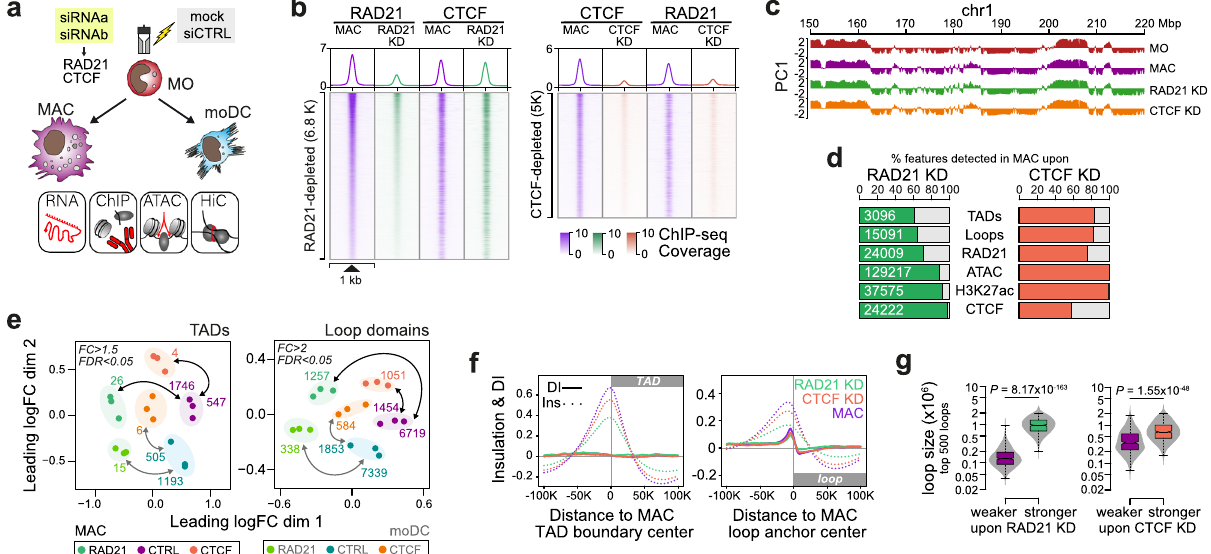
Fig. 5 Cohesin knockdown affects 3D genome architecture during MO differentiation. a Schematic of the experimental setup. MO were either mock- treated or electroporated with control siRNA (siCTRL) or speci fi c siRNAs (targeting CTCF or RAD21 ) and cultured in MAC or moDC culture conditions. b Genomic distance distributions of RAD21 and CTCF ChIP-seq coverage at signi fi cantly reduced RAD21 peaks upon RAD21 knockdown (left panel) or signi fi cantly reduced CTCF peaks upon CTCF knockdown in MAC. c Tracks representing the fi rst eigenvector values (PC1, 50kB resolution) for the indicated cell types. d Effect of the RAD21 or CTCF knockdown on indicated features. Colored bars represent the number of detectable features as percentage of the same feature in control MAC. Numbers represent feature counts in control MAC. e MDS plots comparing TAD and loop score data sets of the indicated conditions. Numbers of signi fi cantly different domains are indicated. f Histogram of insulation scores (Ins) and directionality indices (DI) across all loop anchor regions for siRNA-treated or control MAC. g Distribution of loop sizes for the top 500 domains gained or lost upon RAD21 or CTCF knockdown in MAC. Solid bars of boxes represent the interquartile ranges (25 – 75%) with an intersection at the median; whiskers represent max/min values; P values: Mann – Whitney U-test, two-sided. ( f , g ) Source data are provided as a Source Data fi